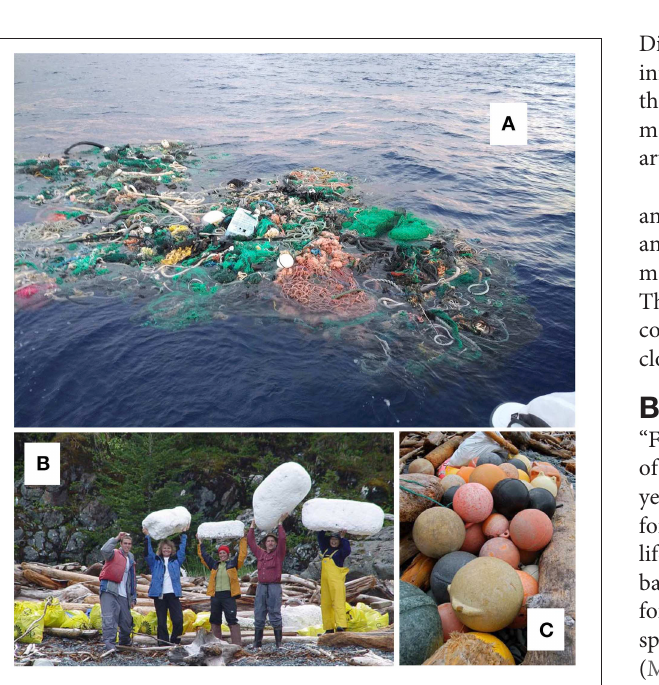
origin. Other types of debris or their parts float initially, but gradually lose their buoyancy due to biofouling and degradation, processes that may remove debris from the sea surface. Wooden debris, by being exposed to water may saturate and increase its density and sink. The ocean floor is difficult to study